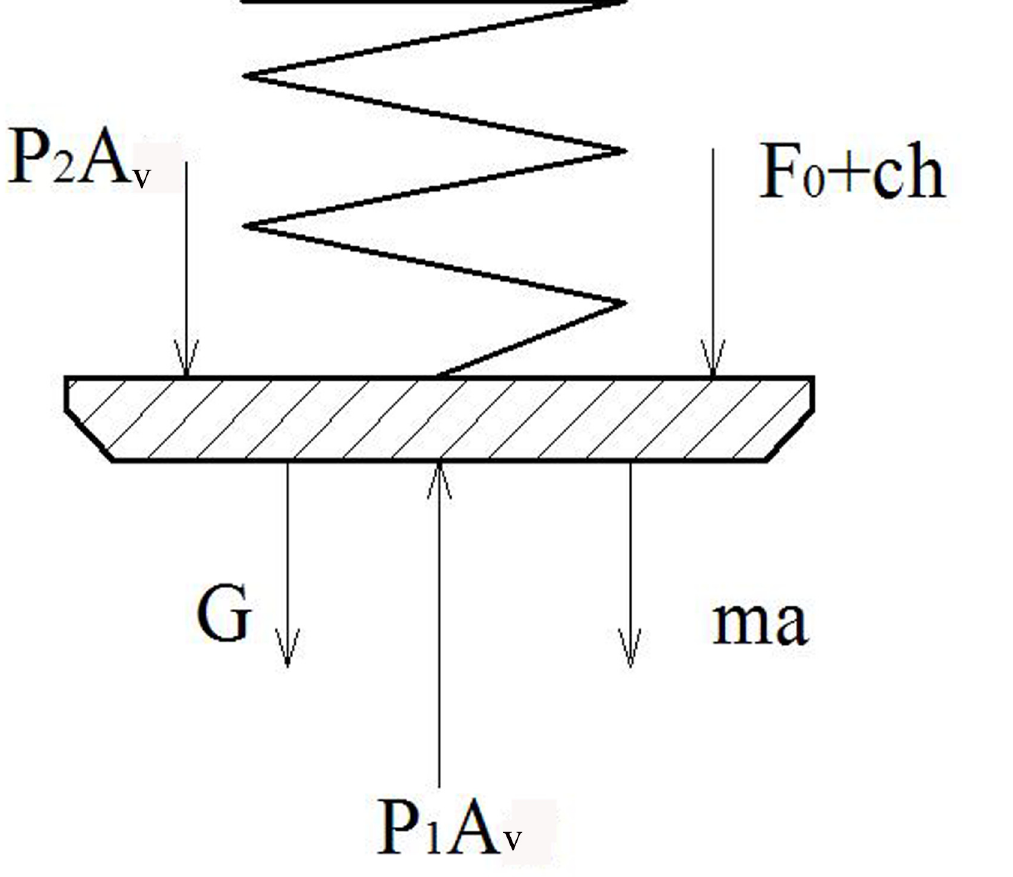
Fig 3. Schematic diagram of forces applied to